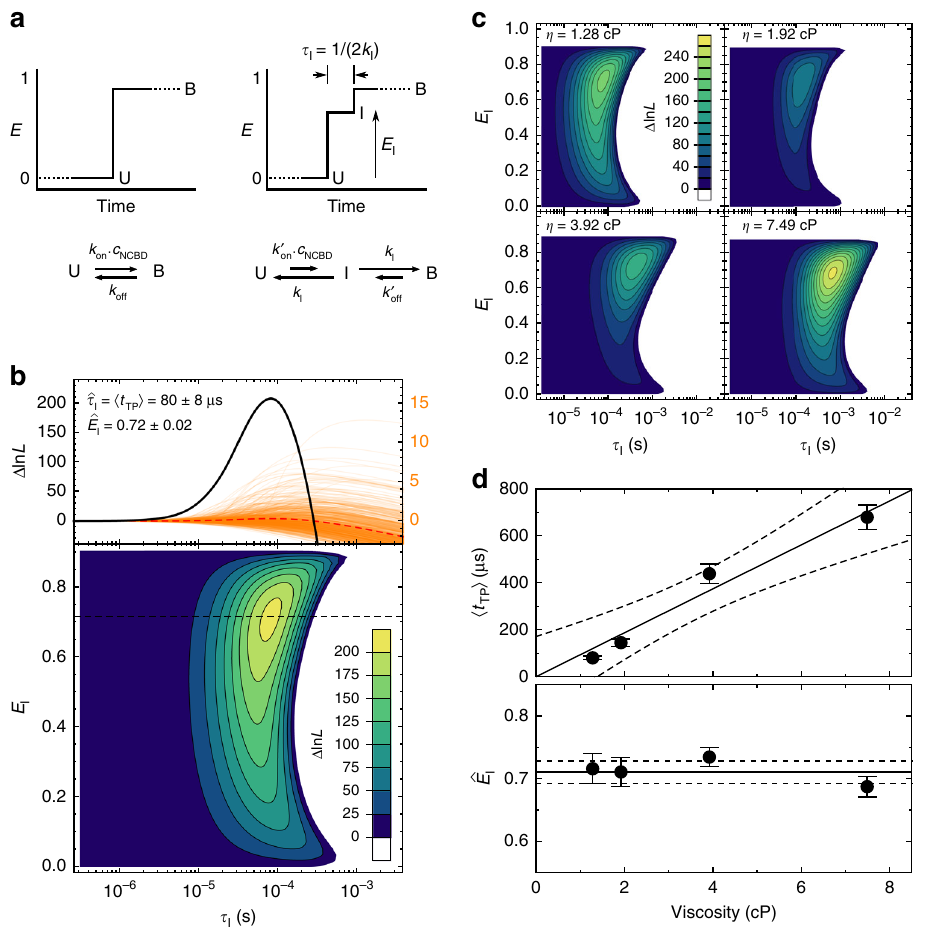
Fig. 2 Quantifying transition path times. a The two kinetic models compared in the maximum likelihood analysis include the unbound (U) and bound (B) states; the second model accounts for a fi nite duration of a transition path by also including an intermediate state (I) with transfer ef fi ciency E I and mean lifetime τ I . b Log likelihood difference ( Δ ln L ) plots for binding transitions (ionic strength 108 mM, viscosity 1.28 cP). The 2D contour plot (lower panel) shows the total Δ ln L of all 686 transitions for different values of τ I and E I . The maximum yields ^ τ I and ^ E I , the most likely values of τ I and E I , respectively, Δ ln L h i . The top graph shows the Δ ln L plots for ^ E with ^ τ I ¼ t I (black dashed line in the contour plot). The j plots of all individual measurements are shown TP (orange lines, right scale), with their average (red dashed line, right scale) and their sum (black line, left scale). c Δ ln L contour plots of transitions measured at different solvent viscosities ( η ). From the lowest to the highest viscosity, sample sizes were 686, 331, 285, and 378 transitions (see Supplementary Table 3). d Solvent viscosity dependence of 〈 t TP 〉 (with linear fi t, constrained to 〈 t TP 〉 ≥ 0 at zero viscosity, and 90% con fi dence interval) and ^ E I (average: solid line; standard deviation: dashed lines). Error bars indicate standard errors obtained from 1000 bootstrapping